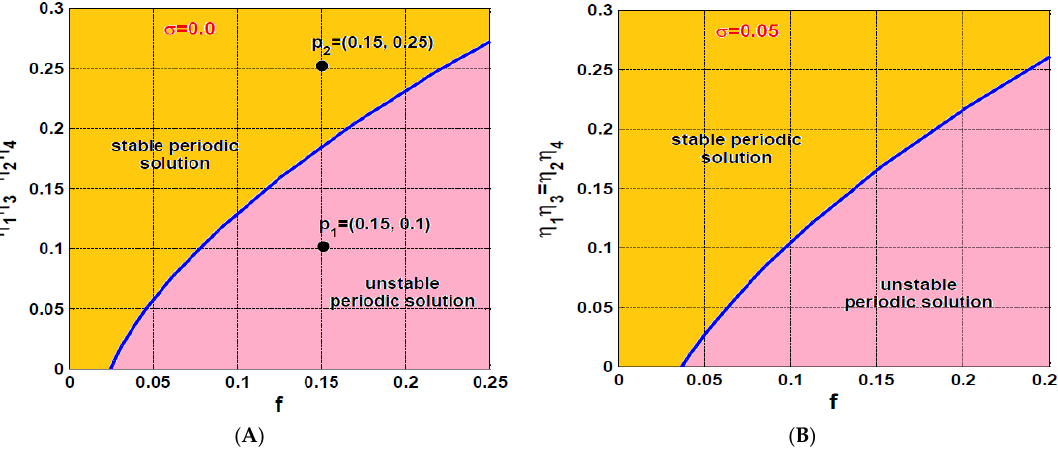
Figure 18. Stability chart of the rotor system in f − η 1 η 3 = η 2 η 4 plane at two different values of σ : ( A ) σ = 0.0, and ( B ) σ = 0.05.